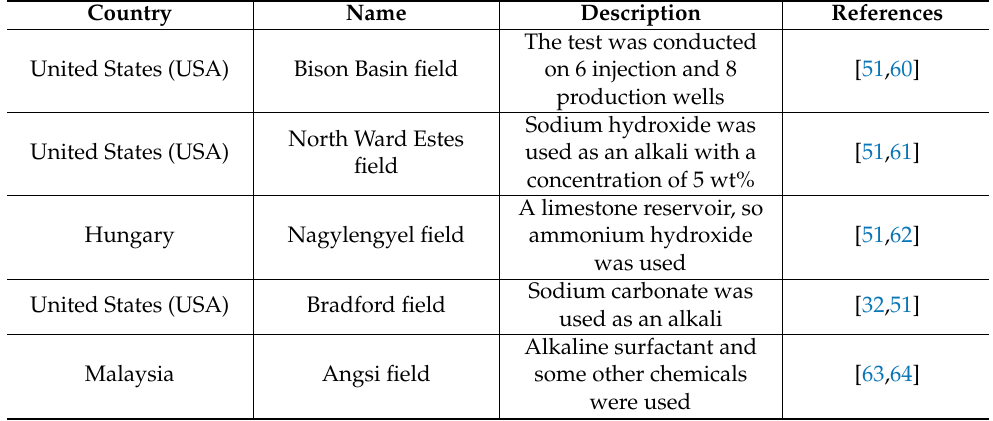
Table 3. Alkaline flooding—field studies.